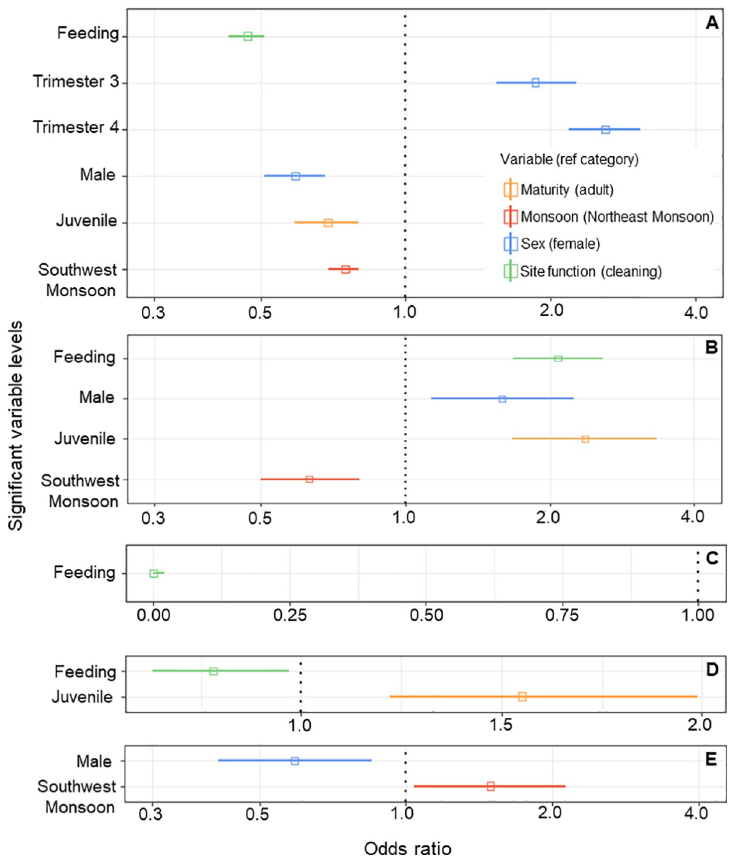
Fig 8. Relationship between hitchhiker species presence and significant explanatory variables ( p < 0.05) in terms of odds ratio (OR). Indicates the likelihood of presence in comparison with the reference category shown in the legend. OR values are plotted with 95% confidence intervals (CI; solid horizontal lines). Where the CI does not span 1, the explanatory variable is significantly more likely when OR > 1, and significantly less likely when OR < 1. (A) Mobula alfredi and Echeneis naucrates , (B) M . alfredi and juvenile E . naucrates , (C) M . alfredi and Lutjanus bohar , (D) M . alfredi and Gnathanodon speciosus presence, and (E) M . birostris and Remora remora